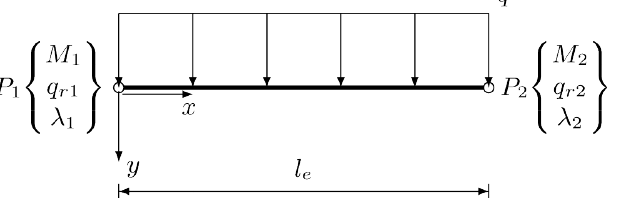
Figure 3. Stress-based beam element with two nodes and six degrees of freedom